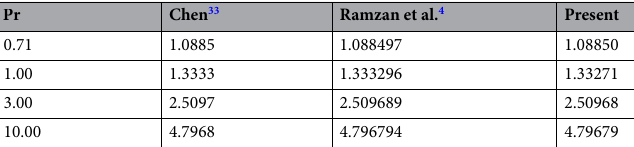
Chen 33 Ramzan et al.